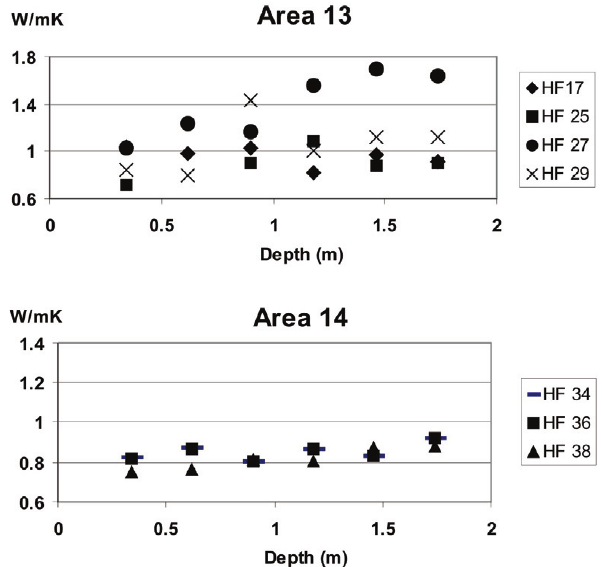
Fig. 2. In-situ thermal conductivities of the marine top sediments were measured by heated line source method at all heat flow sta- tions. With exception of HF17, thermal conductivity values increase with depth.